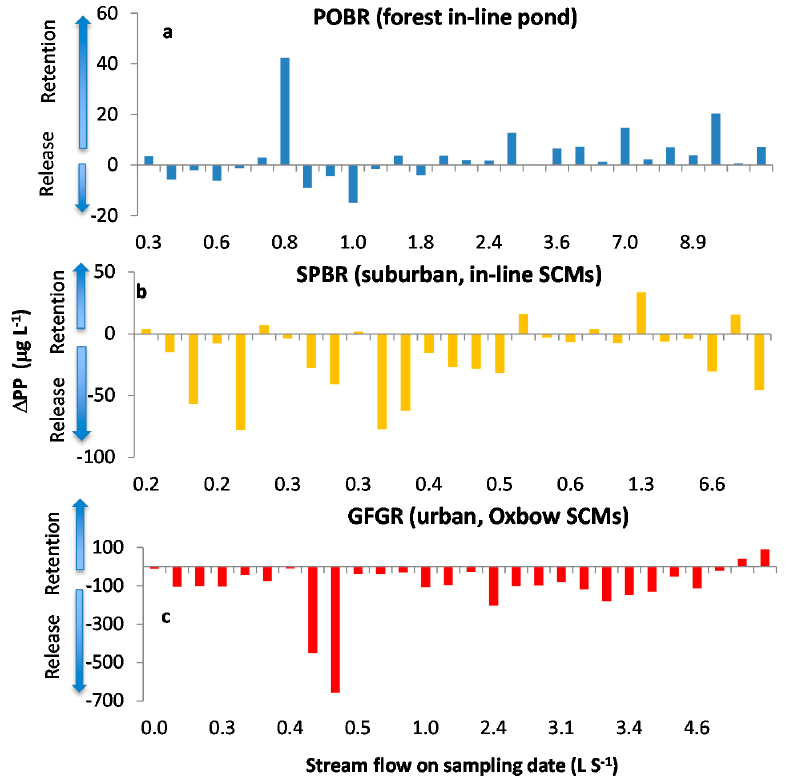
Figure 2. Changes in PP concentrations from inlet to outlet ( ∆ = inlet − outlet) of ( a ) the POBR forest, in-line pond; ( b ) the SPBR suburban in-line SCMs and ( c ) GFGR urban oxbow SCMs across stream flows (from lowest to highest).